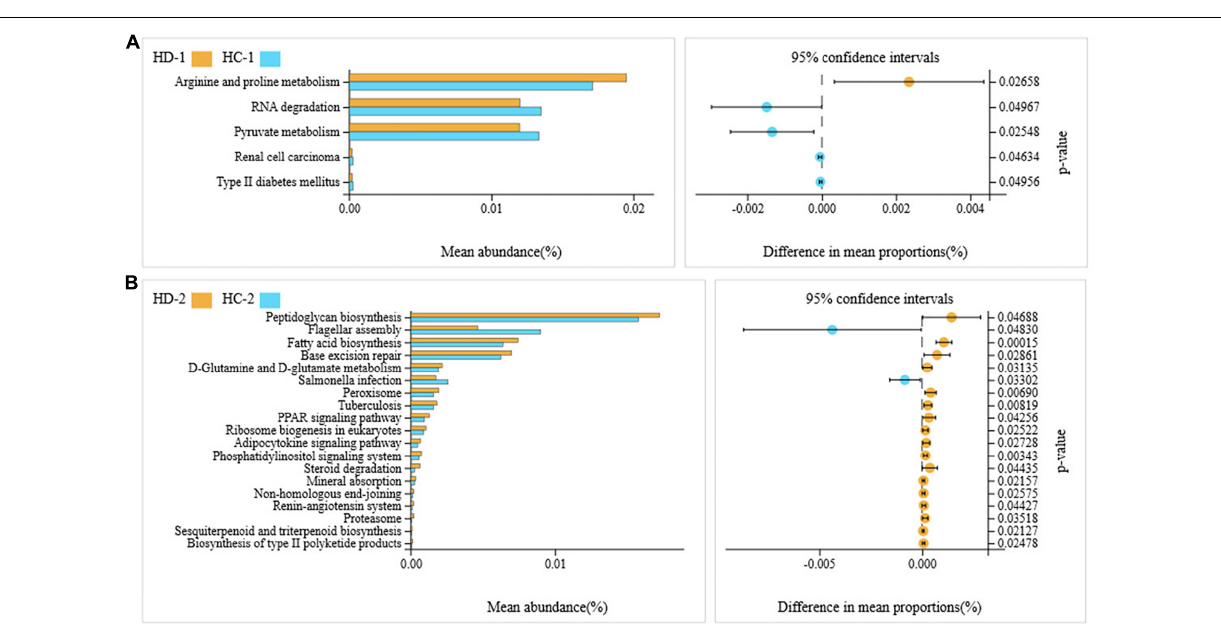
FIGURE 6 | KEGG pathways for bacteria in ileal meconium of neonatal piglets before suckling. HD-1: bacteria of ileal meconium of Hoxa1 − / − neonatal piglets from the control group. HC-1: bacteria of ileal meconium of Hoxa1 − / − neonatal piglets from the experimental group. HD-2: bacteria of ileal meconium of non-Hoxa1 − / − neonatal piglets from the control group. HC-2: bacteria of ileal meconium of non-Hoxa1 − / − neonatal piglets from the experimental group. (A) Hoxa1 − / − piglets. (B) Non-Hoxa1 − / −